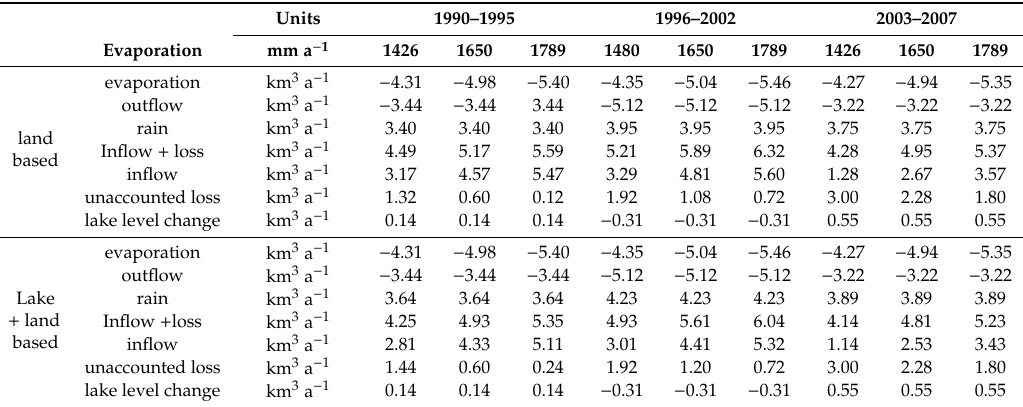
Table A1. Mass balance and calculated inflow and unaccounted losses for Lake Tana for three periods from 1 January 1990–30 May 2007 for three evaporation rates, observed for land-based and lake + land-based precipitation, observed outflow.